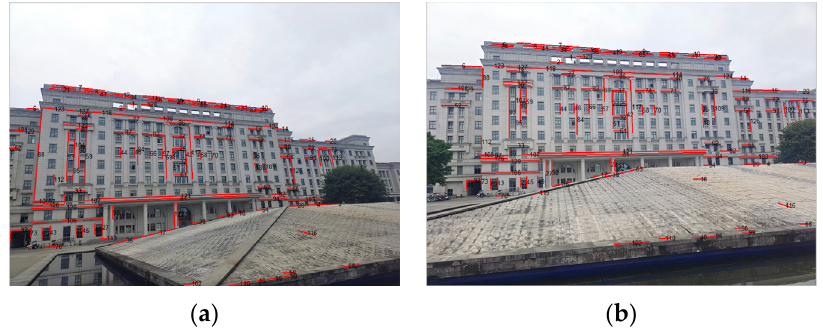
Figure 11. The direct point matching results for the 0°and 15° image of the first scene. The rough matching results for the 0 ◦ and 35 ◦ images of the first scene are presented in Figure 12 and, in total, there are 129 matched line pairs generated by the proposed method.